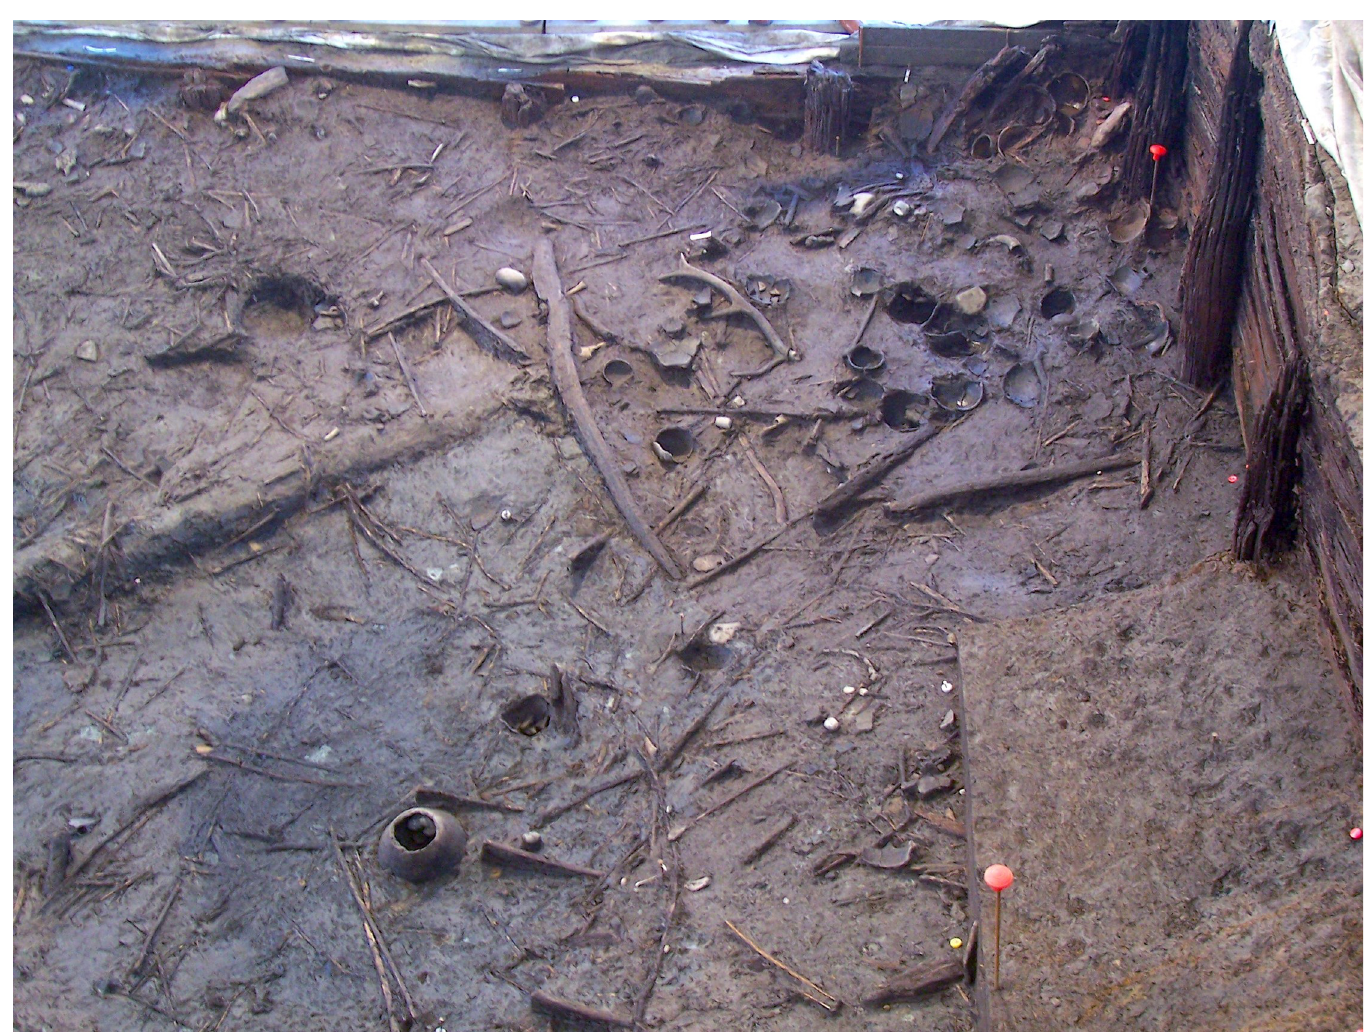
Fig 7. Some of the Bronze Age vessels and wooden items, deposited in the upper tank at Noceto (in situ).